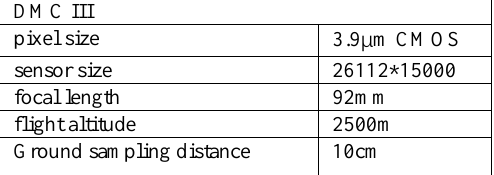
Table 2 Partial parameters of Leica DMC III